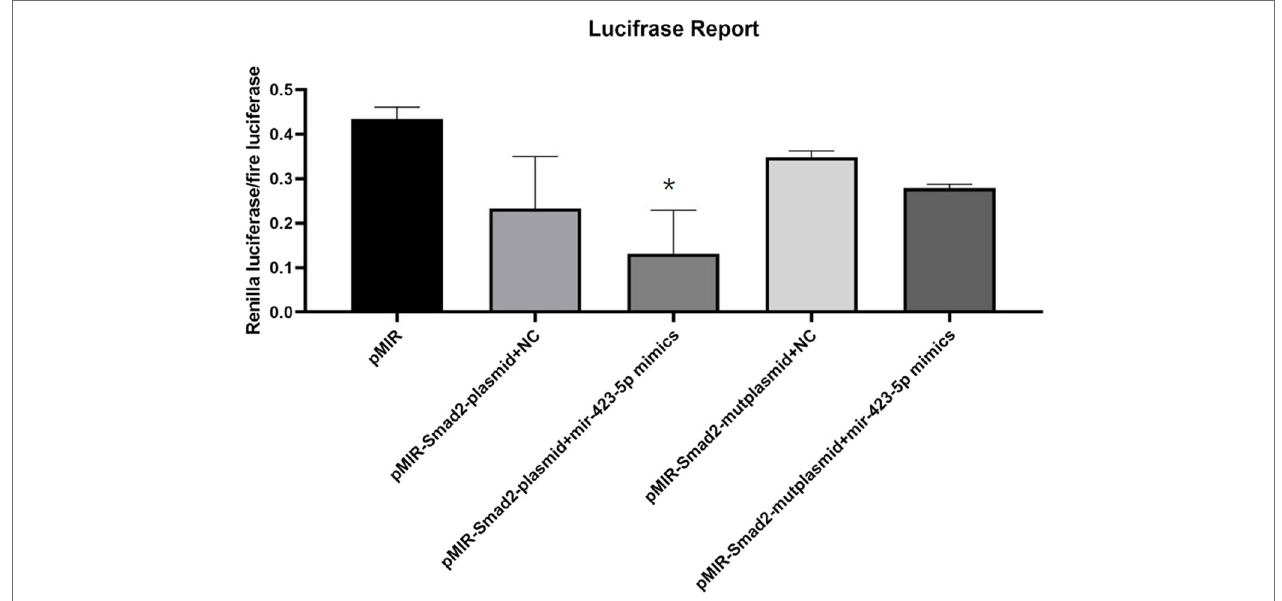
FIGURE 7 | Interaction between miR-423-5p and SMAD2 in vitro. Luciferase reporter assay illustrated the luciferase activity of each group, indicating that miR- 423-5p could interact with SMAD2 mRNA with the indicated binding site, not the mutant binding site. * p <